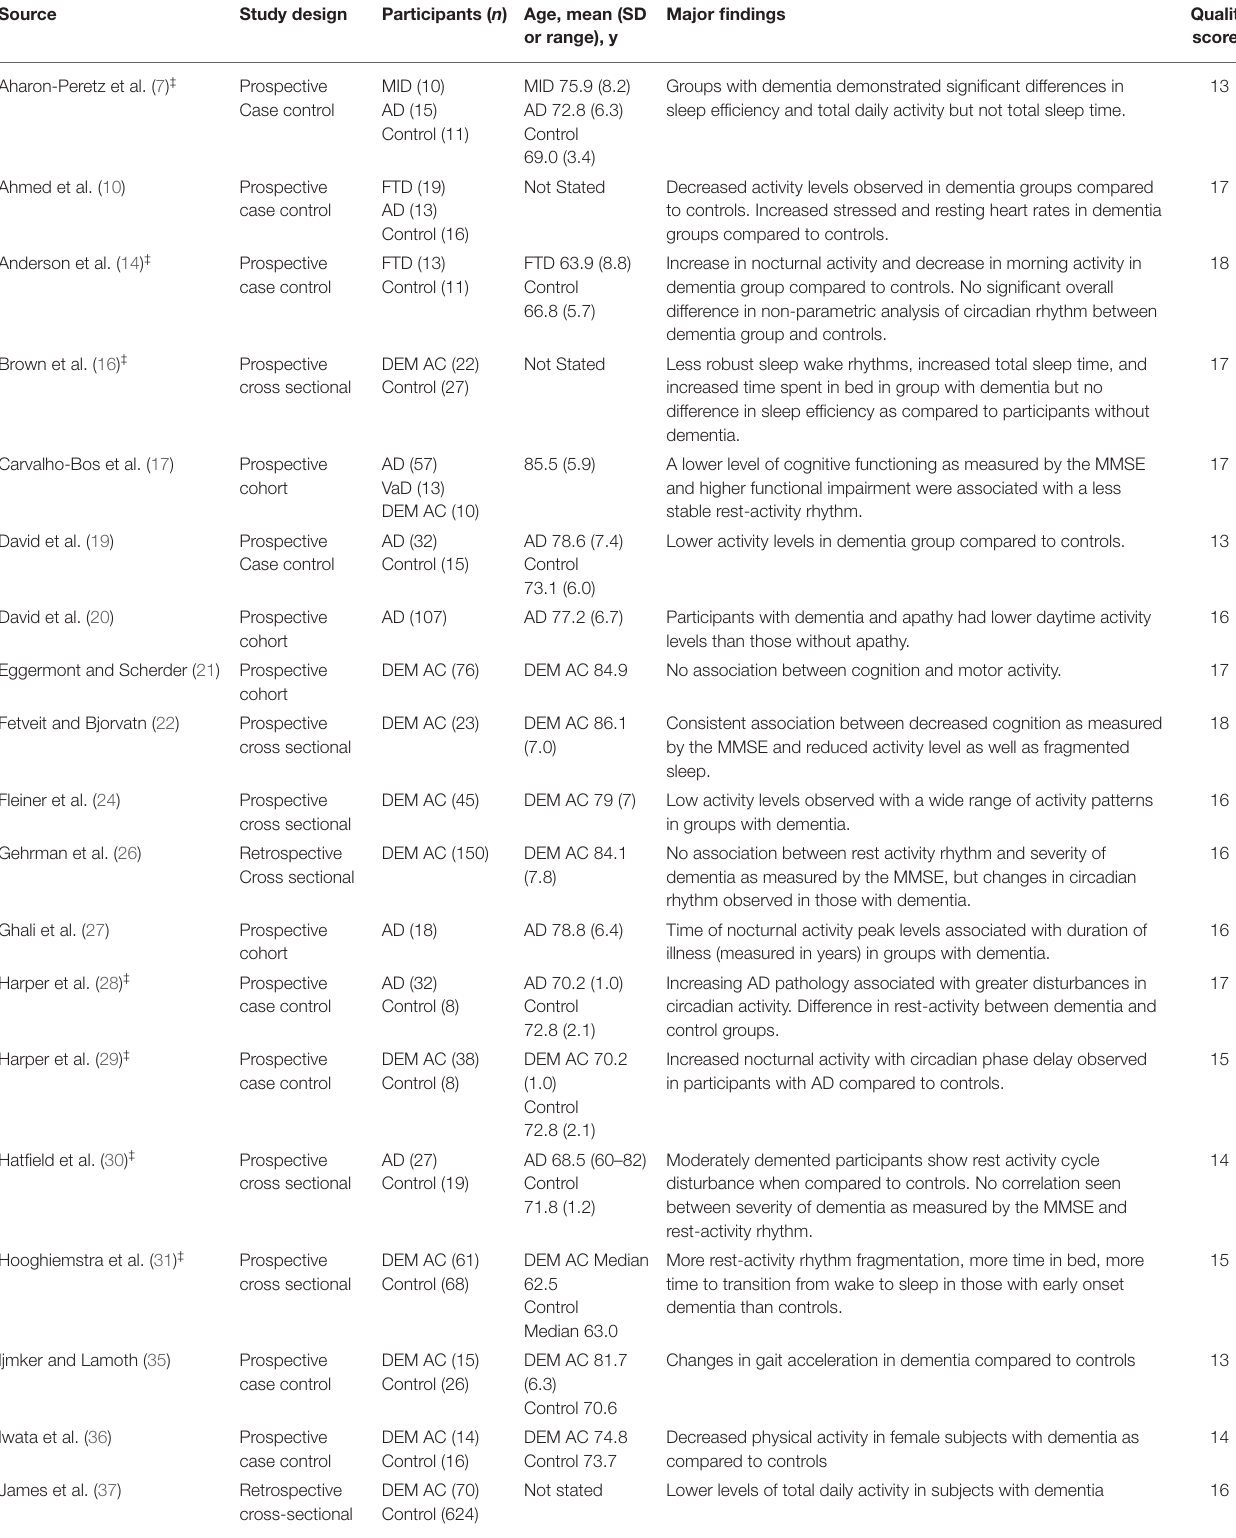
TABLE 6 | Characteristics and major findings of included